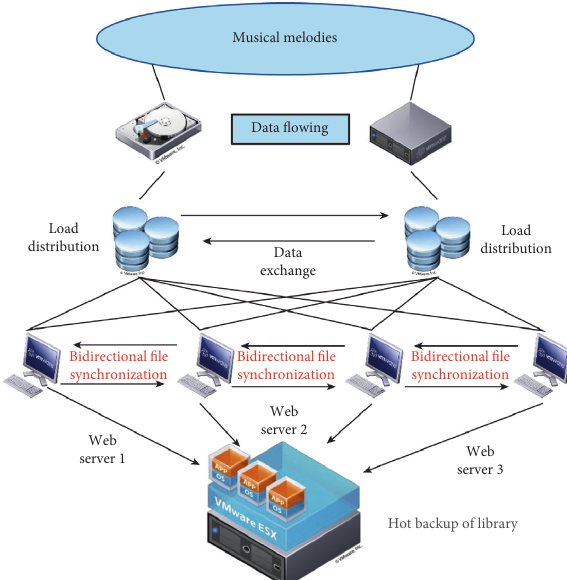
Figure 2: Rhythmic and interval changes in musical